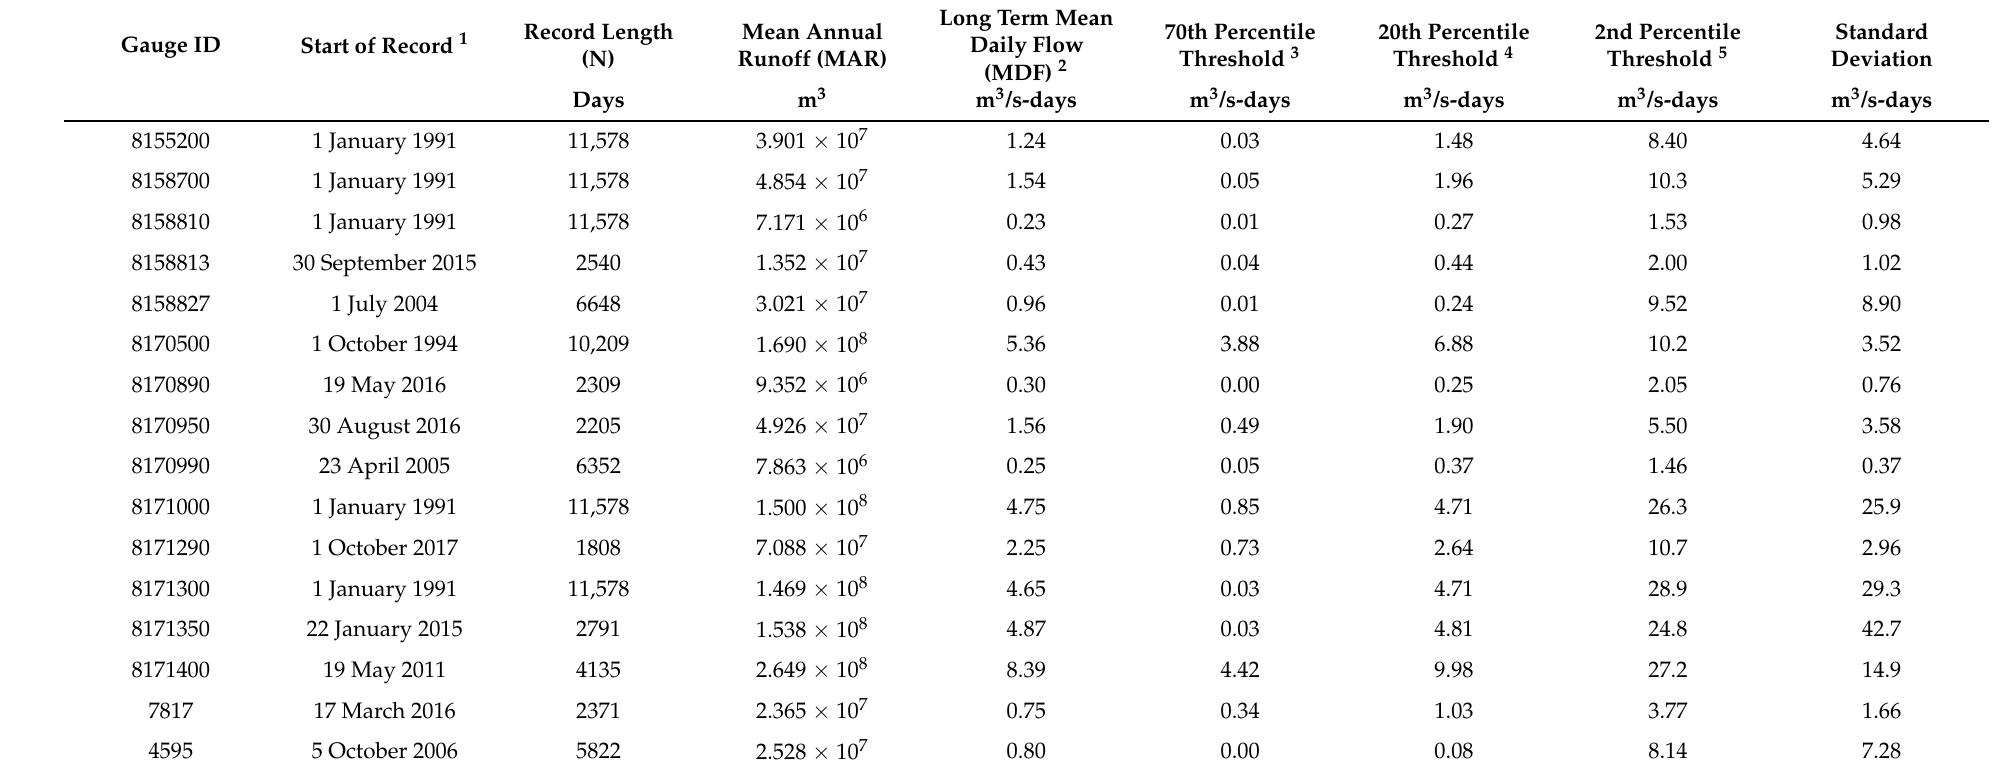
Table 2. Flow duration curve (FDC) analysis